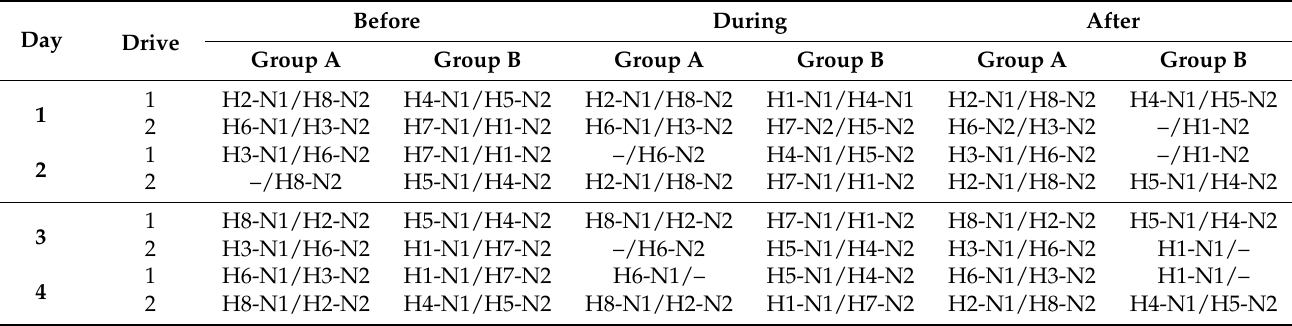
Table 1. Effective pairing of the test (H1–H8) and neutral (N1–N2) horses before, during and after the stay in the social box. Both neutral horses were driven twice per day, so that the first and second drive of the day were also recorded (“drive”). The numbers in bold indicate the days of data collection. Endash (“-“) alone, indicate that the test stallion was driven only once because of specific circumstances such as colic or